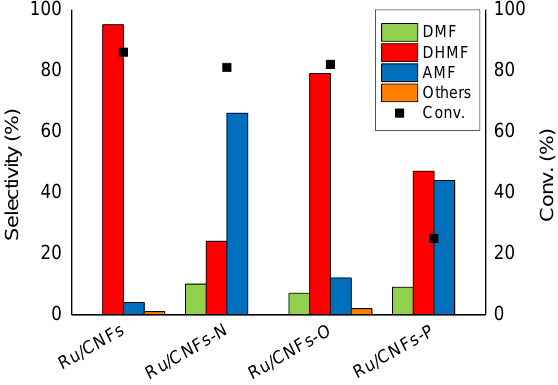
Figure 5. Change in selectivity in the HMF hydrogenation reaction on the different catalysts tested. Reaction conditions: HMF, 0.08 M, substrate/metal = 100 mol/mol, solvent, 15 mL 2-butanol, 150 °C, 20 bar H 2 , reaction time: Ru/CNFs and Ru/CNFs-O 1 h, Ru/CNFs-N and Ru/CNFs-P 3 h.